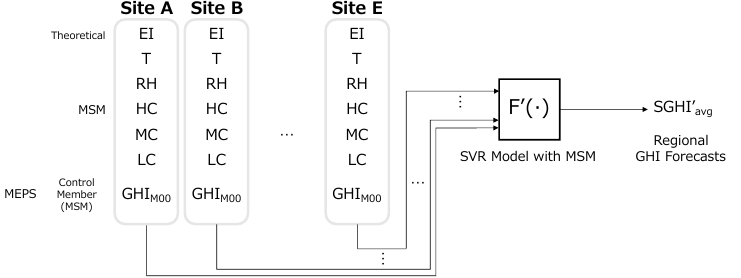
Figure 9. Configuration of SVR models with MSM forecasts. Note that the control member forecasts of MEPS is equal to MSM